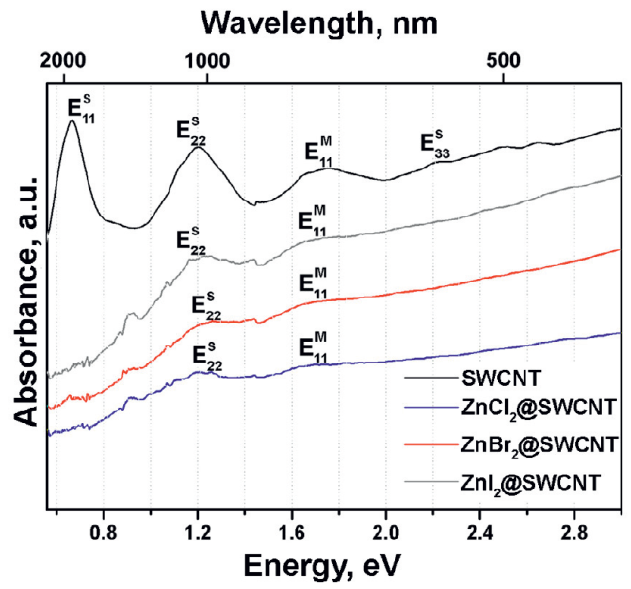
Figure 2. The OAS spectra of the pristine SWCNTs and nanotubes filled with zinc halogenides. Reprinted by permission from [14]: SpringerNature, European Physical Journal B, Kharlamova et al. Acceptor doping of single-walled carbon nanotubes by encapsulation of zinc halogenides, copyright 2012.